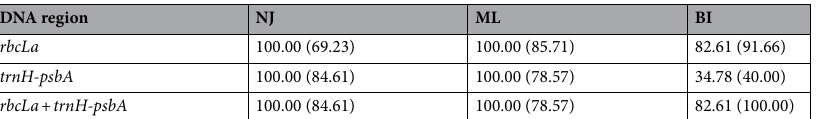
Table 8. Proportion (%) of monophyletic fern species and bootstrap or posterior probabilities, in parentheses, recovered with different phylogenetic techniques (NJ, ML, and BI) using single plastid barcodes rbcLa and trnH-psbA and combined DNA regions.